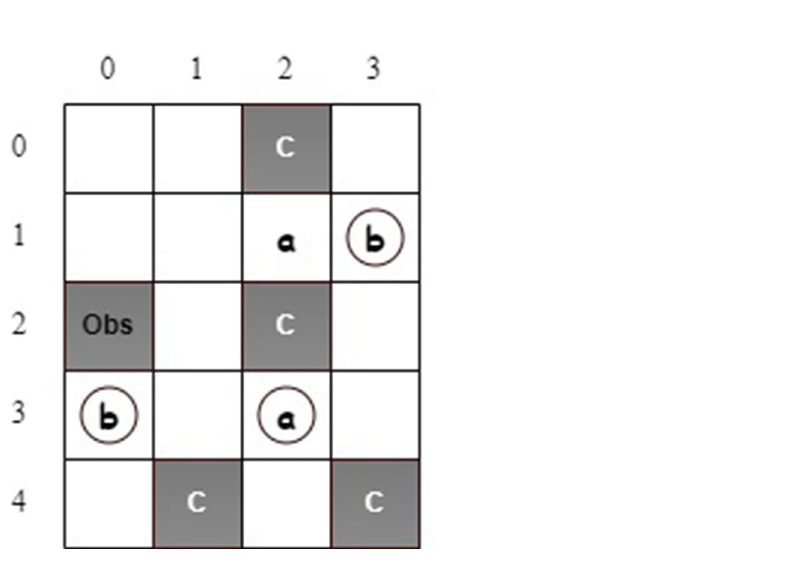
Figure 6. The grid-world with safe absorbing